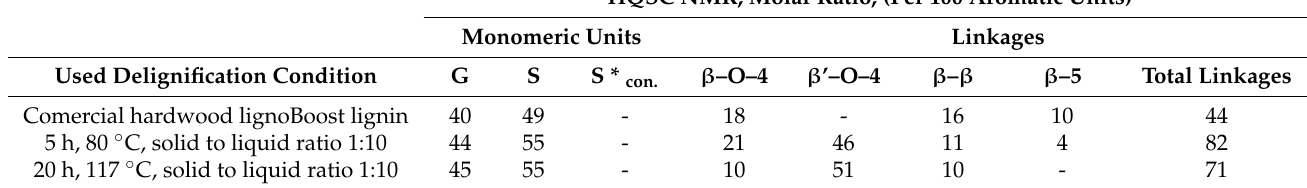
Table 5. Lignin-enriched fraction, obtained using varied conditions, monolignols and dominant linkage distribution as determined by semi quantitative 2D HSQC NMR